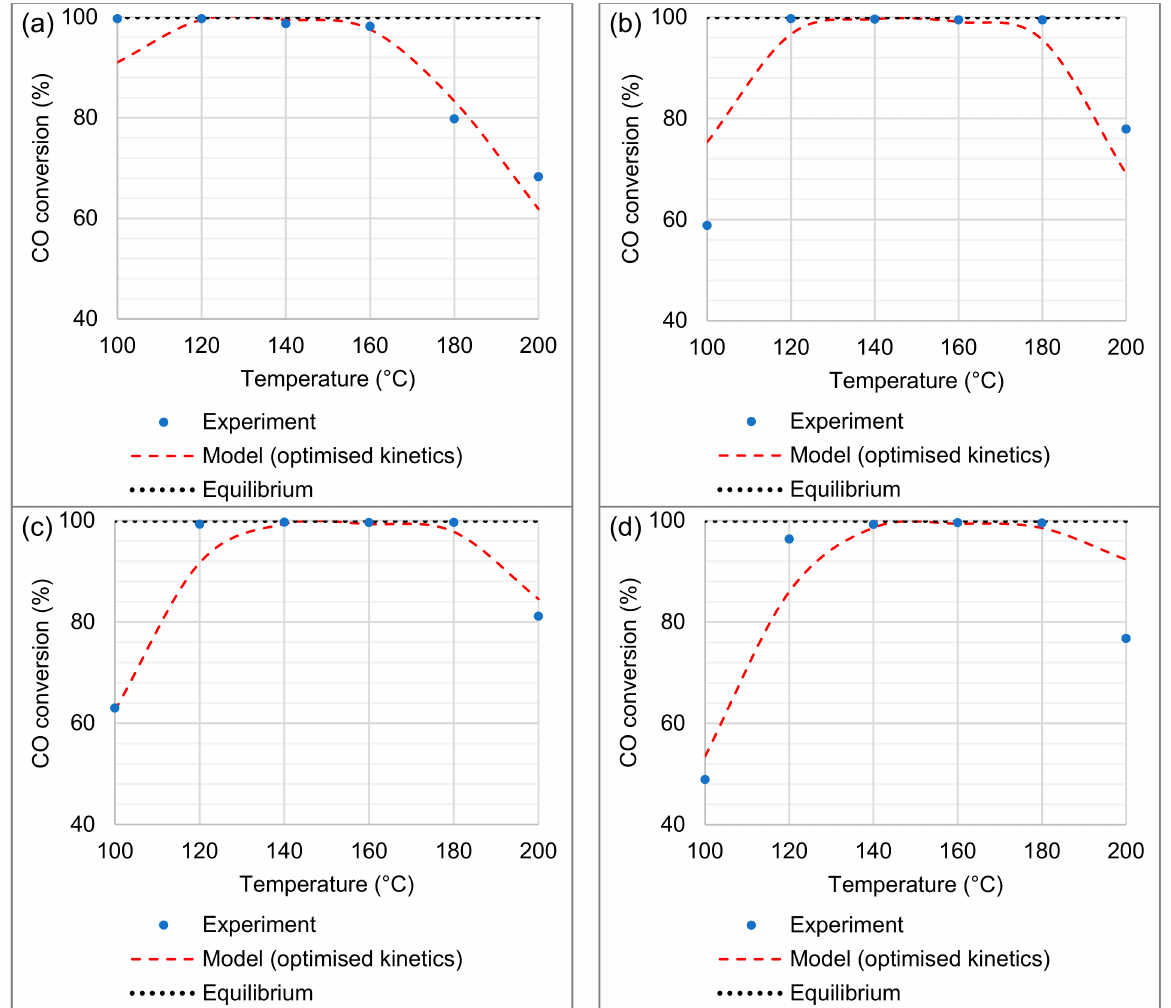
Figure 7. CFD model validation (incorporating CO oxidation, H 2 oxidation, and reversible WGS reactions) to experimental data of CO conversion, in the temperature range 100–200 ◦ C, and for space velocities of ( a ) 32.6, ( b ) 65.2, ( c ) 97.8, and ( d ) 130.4 NL g cat − 1 h − 1 .